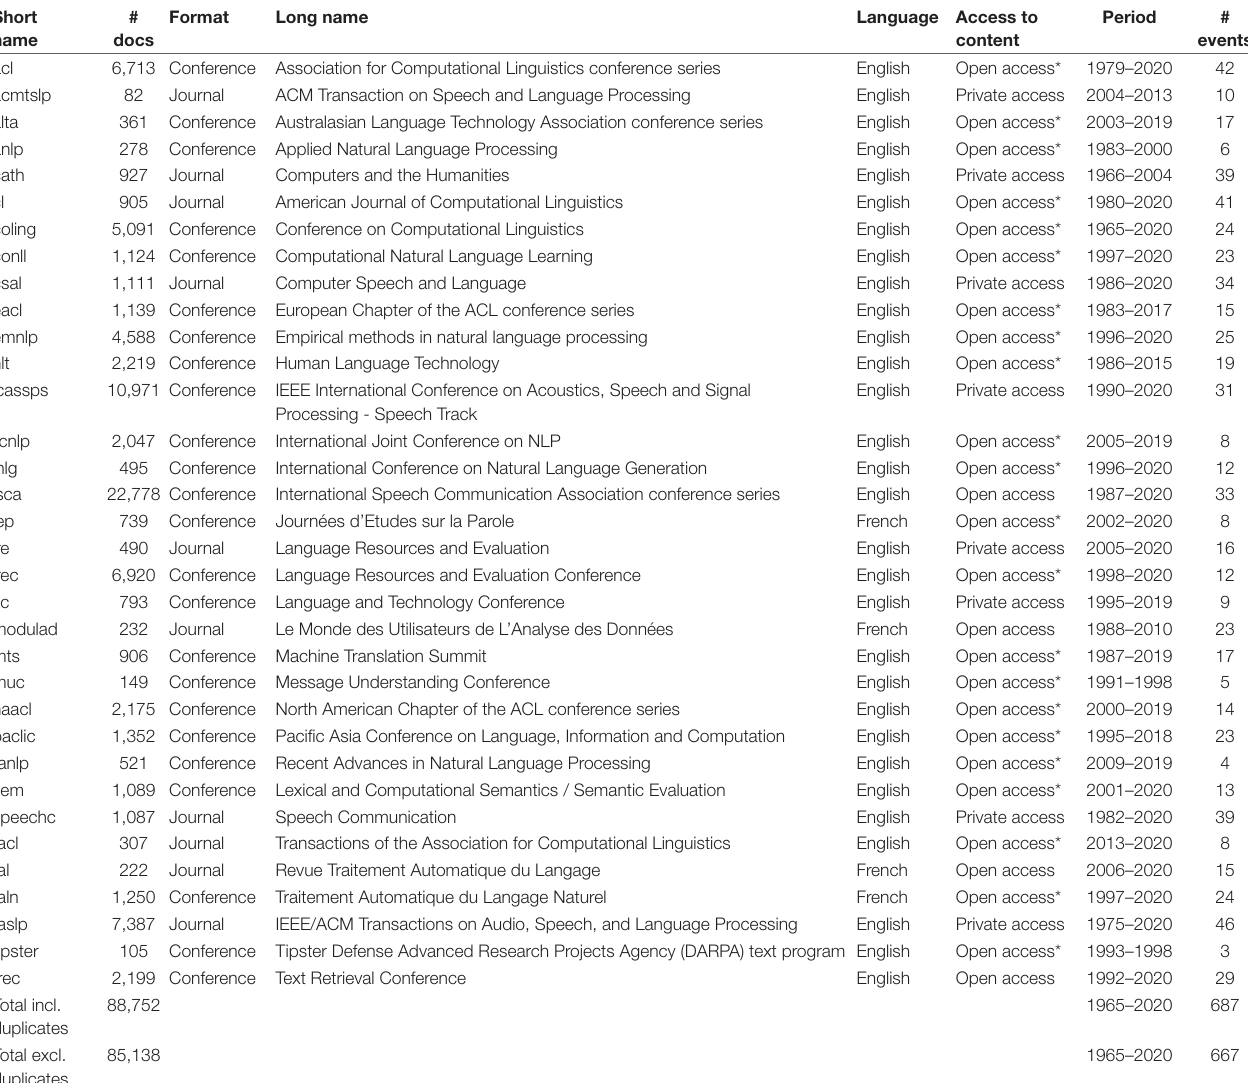
TABLE 1 | The NLP4NLP + 5 corpus of conferences (24) and journals (10).